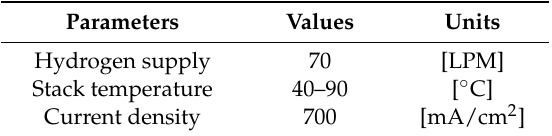
Table 3. Characteristic experimental conditions of fuel